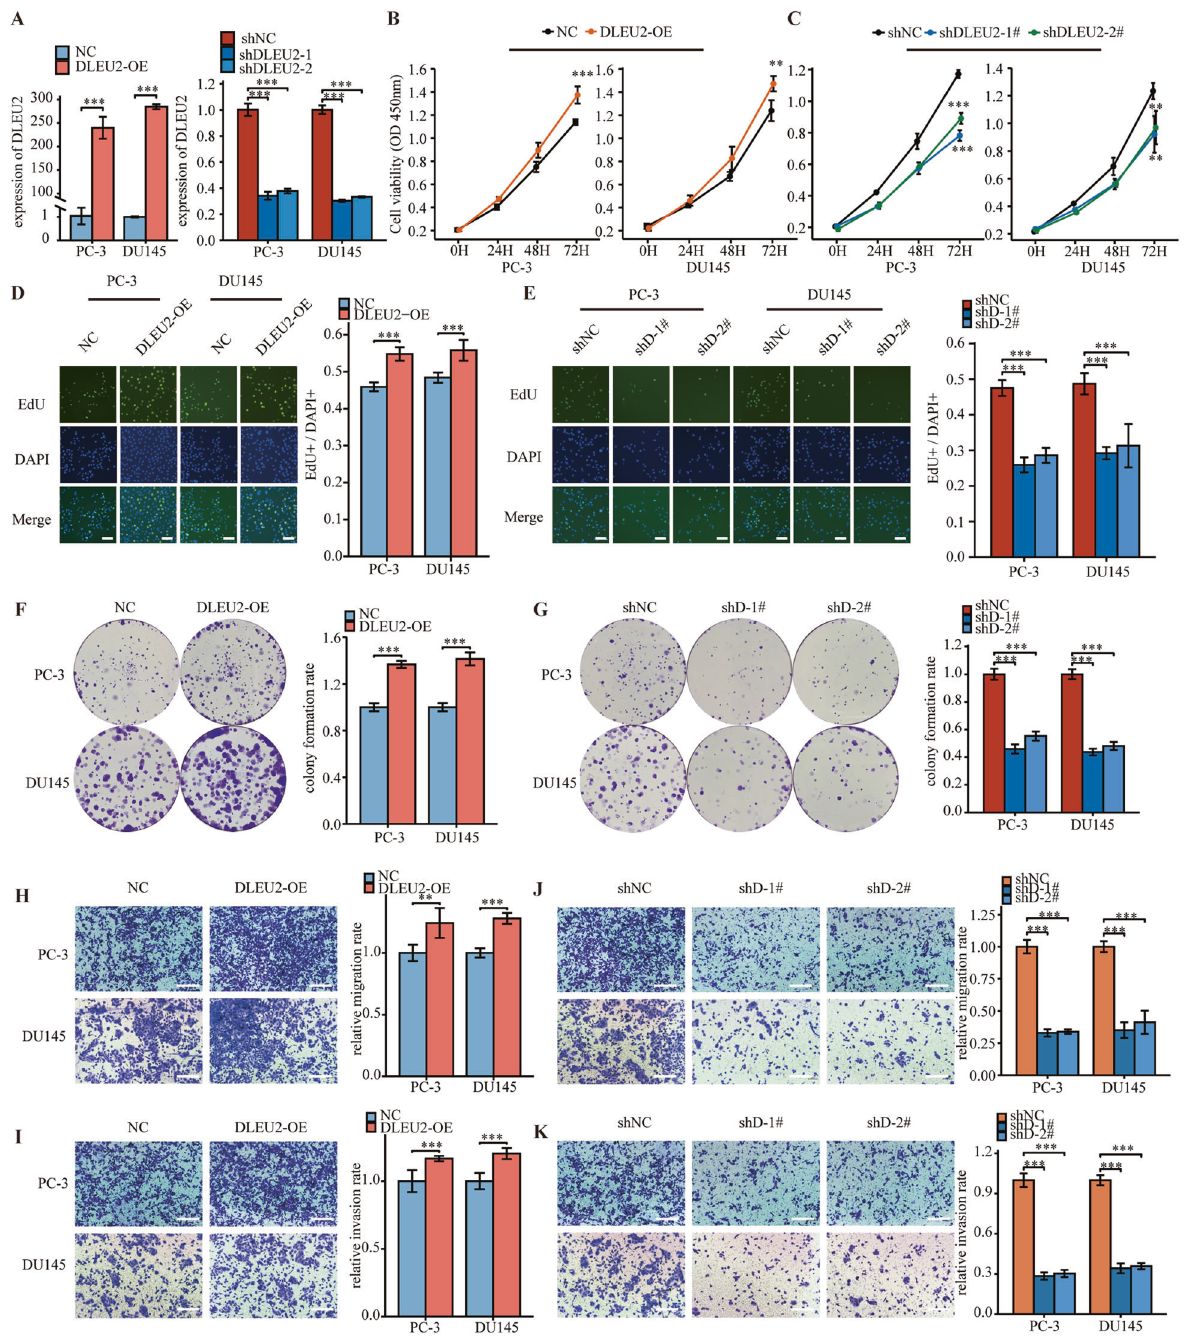
Fig. 2 DLEU2 regulated proliferation, migration, and invasion in prostate cancer cells. A qPCR analysis showing the overexpression and knockdown ef fi ciency of DLEU2. B , C Analysis of cell viability in DLEU2 overexpression and knockdown prostate cancer cells using CCK-8 kit. D , E Result of EdU assay showing the cell proliferation in DLEU2 overexpression and knockdown prostate cancer cells (scale bar: 50 μ m). F , G Colony formation assay was performed to determine the proliferation of PC-3 and DU145 cells harboring the different vectors indicated. H , I Transwell assays were performed to determine the migration and invasion capacity of PC-3 and DU145 cells transfecting with DLEU2 (scale bar: 50 μ m). J , K Transwell assays were performed to determine the migration and invasion capacity of PC-3 and DU145 cells stably expressing shRNAs targeting DLEU2 (scale bar: 50 μ m). Data were indicated as mean ± SD, ns P ≥ 0.05, * P < 0.05, ** P < 0.01, *** P <